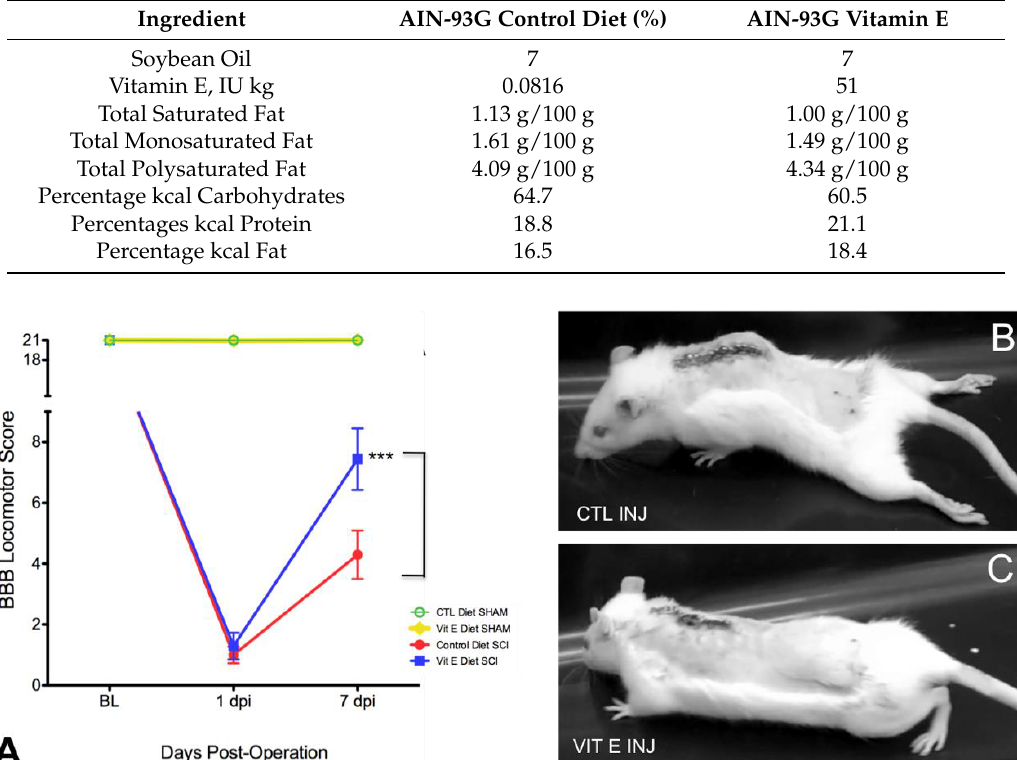
Figure 2. Beneficial effects of dietary vitamin E prophylaxis on the hindlimb neurological function of rats after a moderate injury, as assessed by the Basso-Beattie-Bresnahan (BBB) locomotor rating scale. ( A ) Effects of dietary vitamin E prophylaxis on locomotor function. Time (in days) following pretreatment and spinal cord compression (injury) is shown on the horizontal axis, BBB locomotor rating scores are shown on the vertical axis. Injured rats in the dietary vitamin E prophylaxis group had higher BBB scores of at least 7 when compared to controls. Open-field locomotion still images from control diets- ( B ) and dietary vitamin E prophylaxis rats ( C ) at 7 days post-injury (dpi). Mean dietary vitamin E prophylaxis scores revealed that most rats exhibited extensive movements of three joints with dorsal-stepping patterns at 7 dpi. Bonferroni test analysis was carried out to determine the statistically significant differences between diet treatments. Error bars represent means ± standard error of the mean (CTL INJ versus VIT E INJ *** p < 0.001; CTL INJ, n = 14; VIT E INJ, n = 12). CTL = control, VIT = vitamin, INJ = injury Table 1. Detailed diet composition for Control and vitamin E-Enriched Diet. Ingredient AIN-93G Control Diet (%)